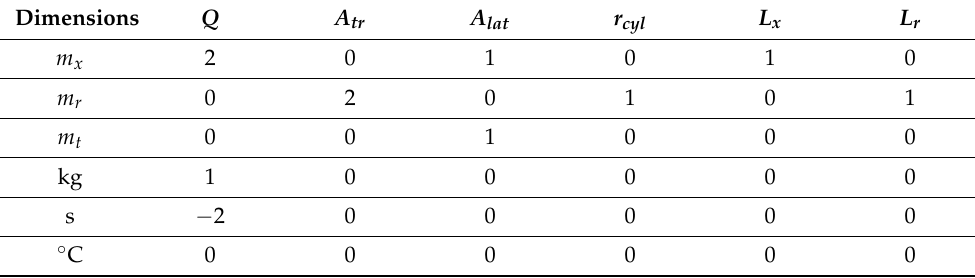
Table 8. The quantities required by experiments (part of matrix B).